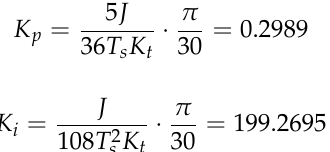
Table 2. The parameters of the PID, the SMC and the ADRC controllers. PID SMC ADRC K p = 1.25 K p = 1.25 K pc = 3141.6 K i = 69.7917 K i = 69.7917 b c = 83.33 Current control K p = Speed control